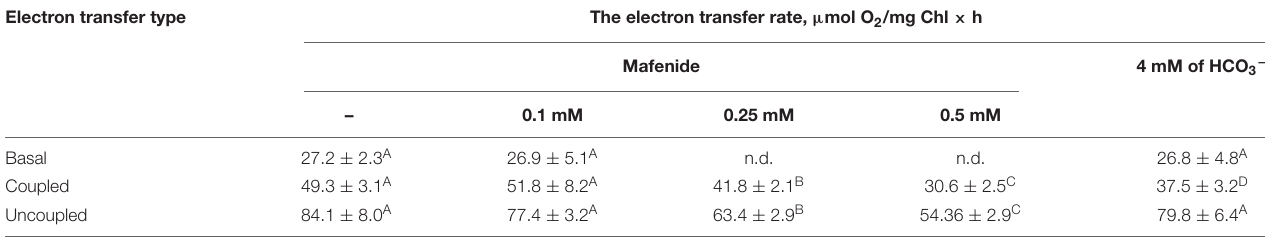
TABLE 1 | Effect of mafenide and bicarbonate on electron transfer rates in Arabidopsis thaliana thylakoids. Electron transfer